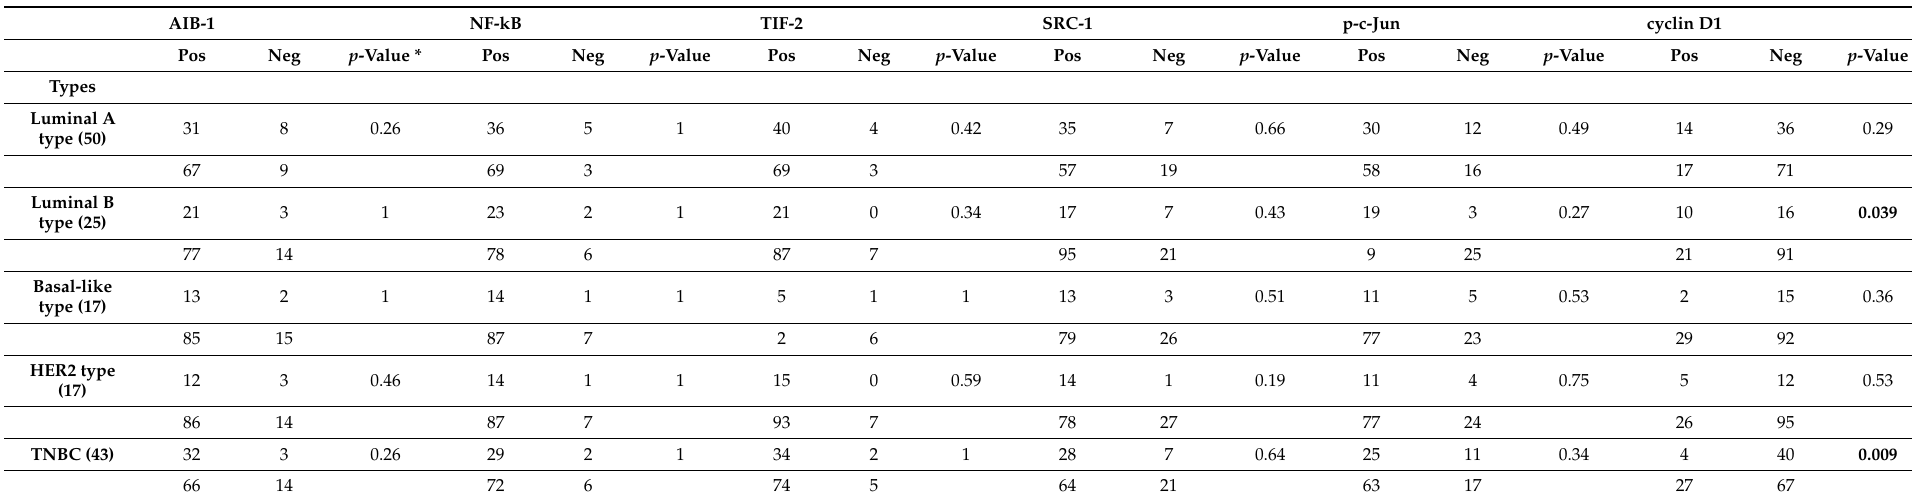
Table 3. Associations between coactivators and molecular types of breast